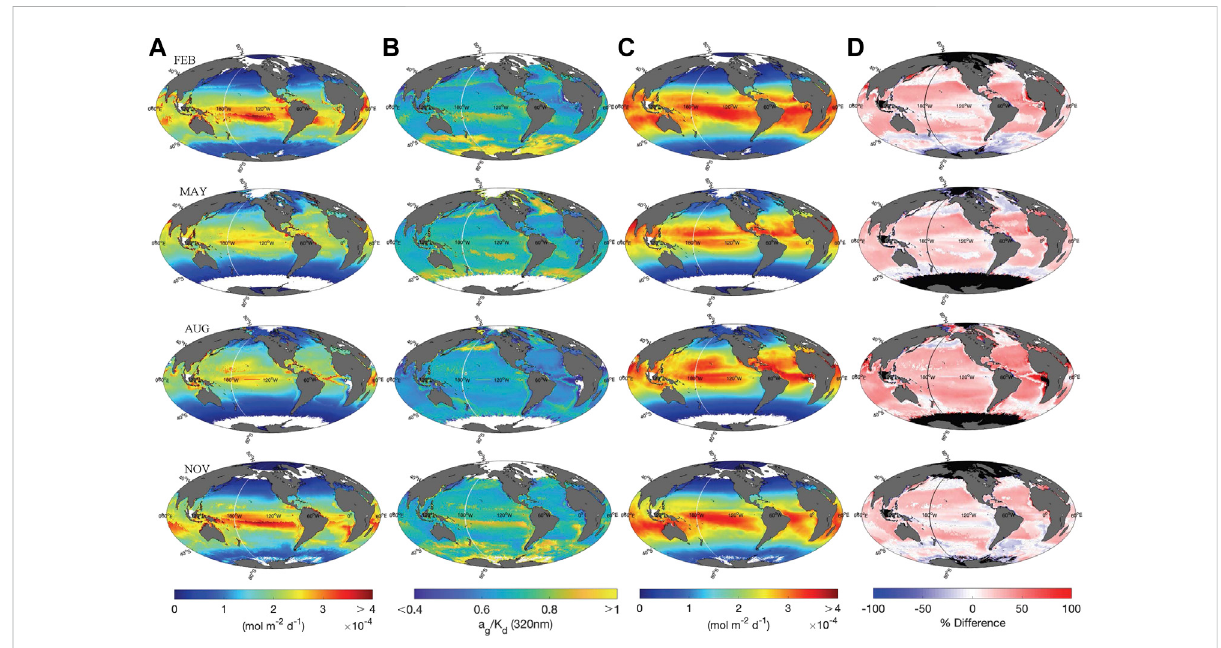
FIGURE 6 (A) Global maps of P H , (B) a g to K d ratios at 320 nm, (C) P H 2 O 2 , integ calculated from P H 2 O 2 , integ ′ × 100. Data in February, May, August and November are displayed. White color in panel (A – C) and black color in panel (D) indicates no